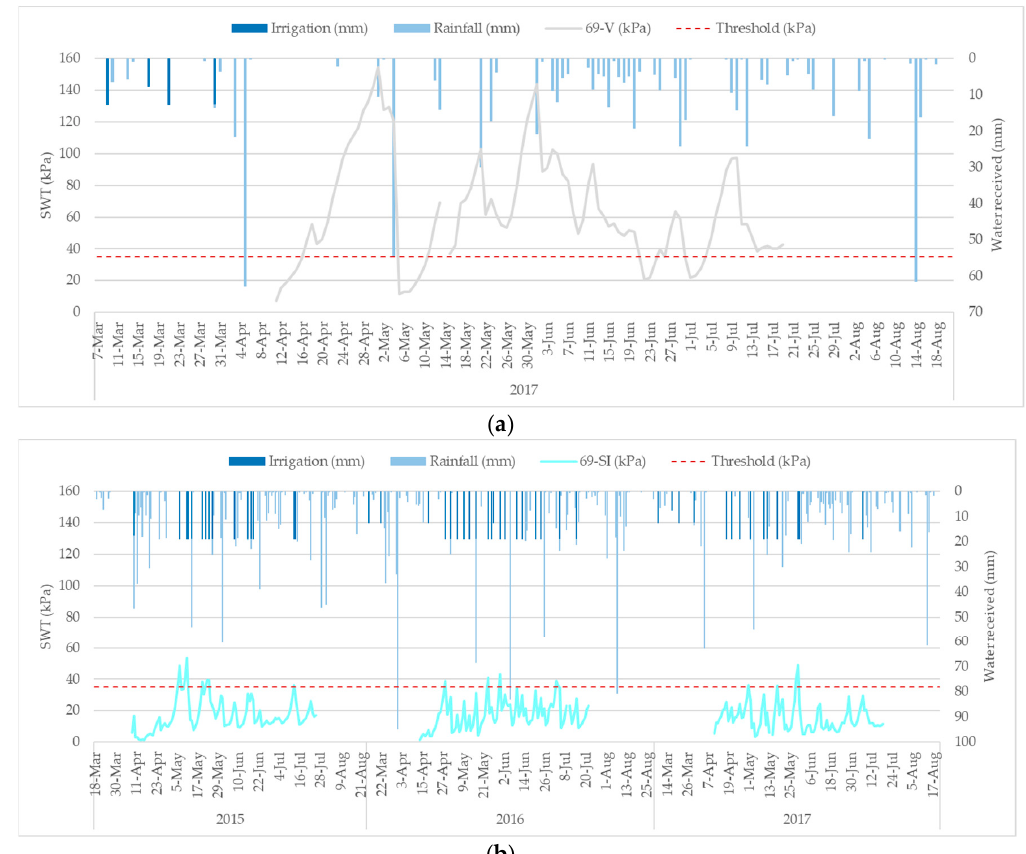
Figure 6. Daily average Soil Water Tension (SWT) data for each plant density and total amount of water received through applied irrigation or rainfall in ( a ) conservation and ( b ) conventional tillage during 2015, 2016, and 2017 growing seasons.